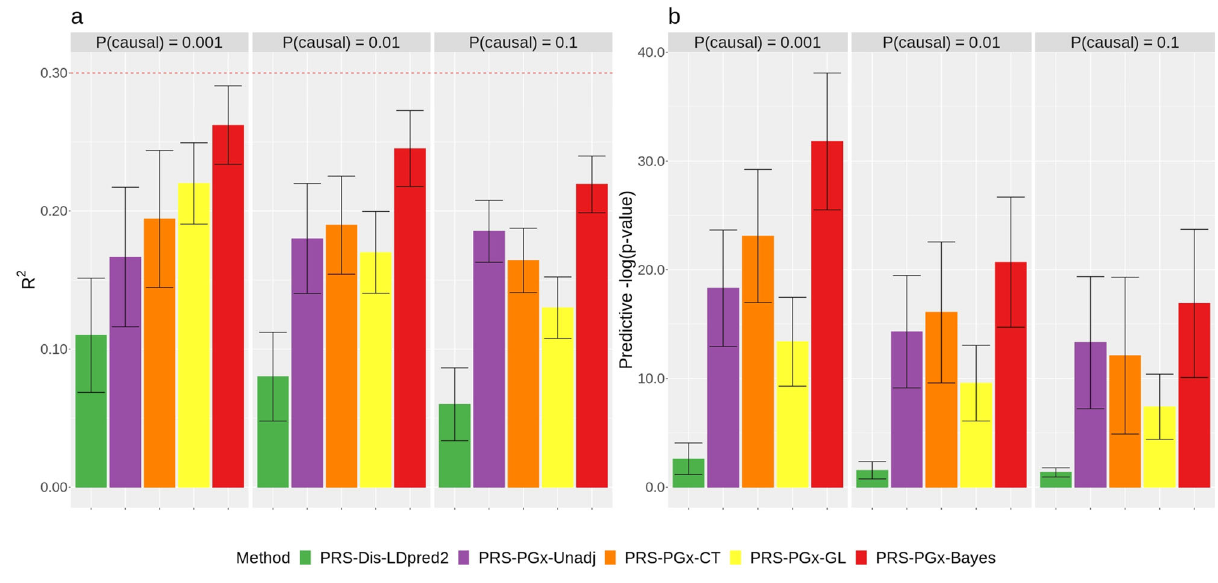
Fig.3|The drug response prediction performance comparison among fi ve methods based on the simulated data with completely separate prog- nostic and predictive SNPs and heritability fi xed at 0.3. The training sample size for PGx PRS approaches was fi xed to be 3000. Numbers of the causal variants for P(causal)= 0.001, 0.01, and 0.1 are 5, 50, and 500,